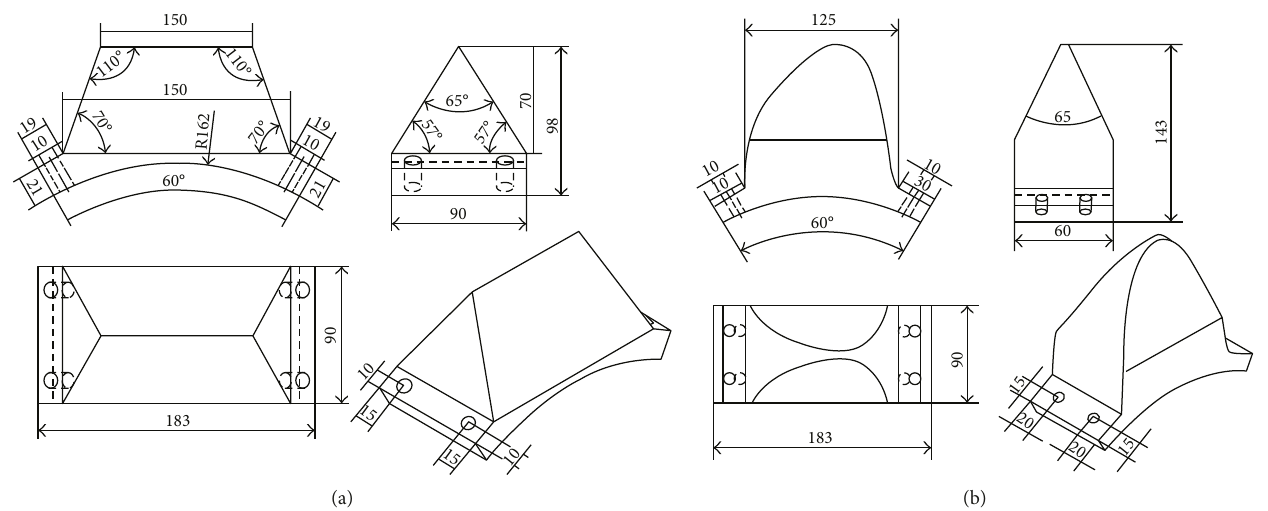
Figure 7: Scale drawing of di ff erent types tooth. (a) Conventional tooth. (b) Bionic